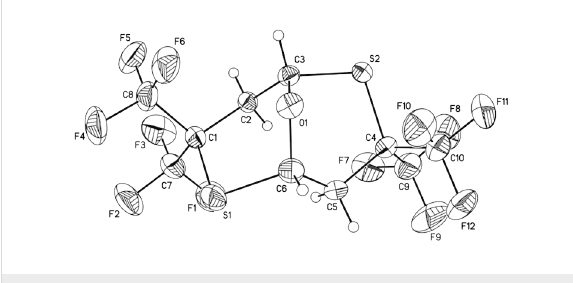
Figure 2: ORTEP drawing of 5 with thermal ellipsoids drawn to the 50% probability level.